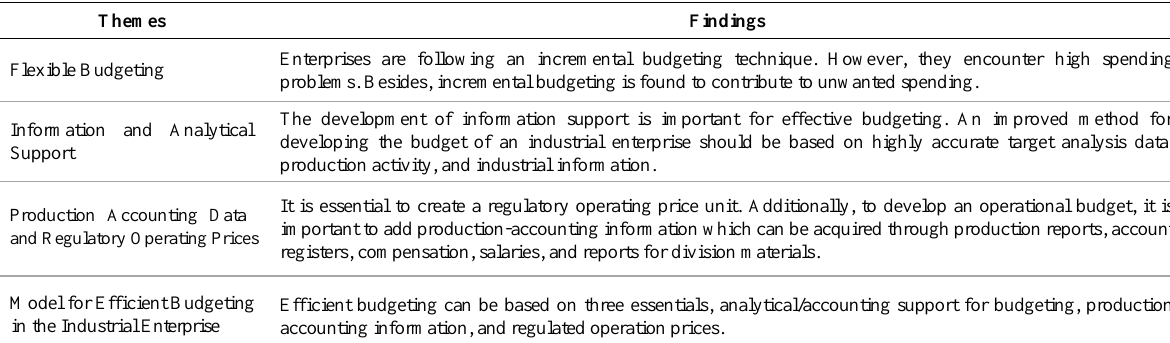
Table 1. Analysis of new scientific